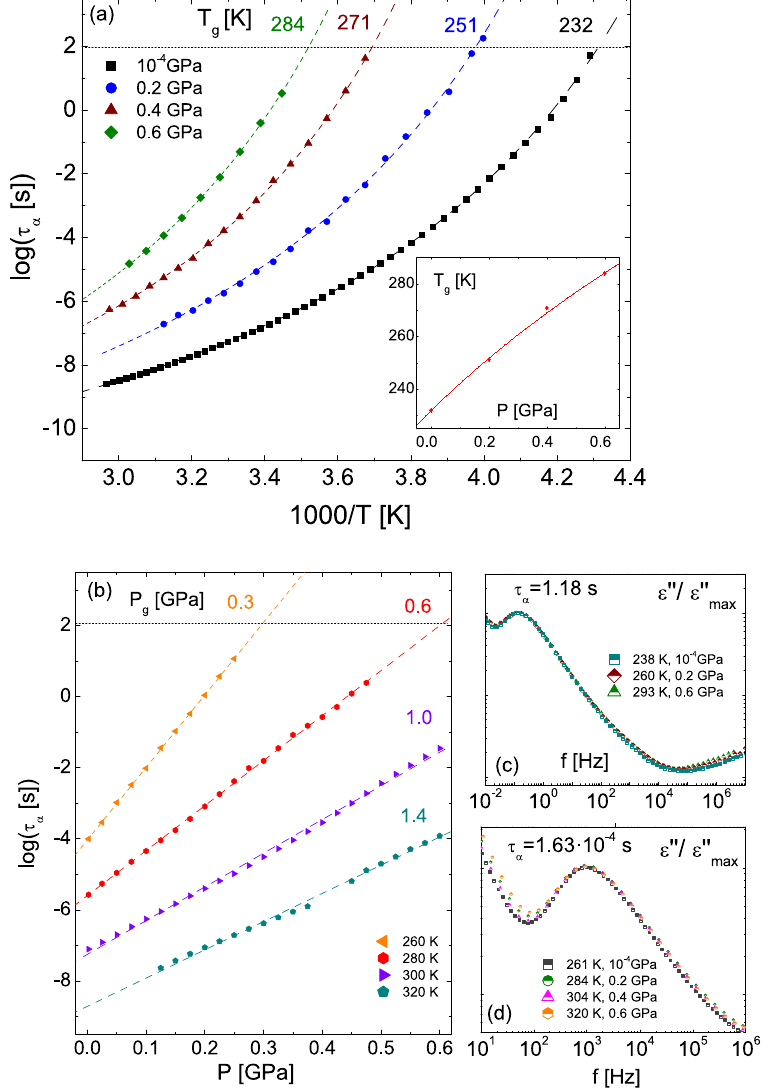
Figure 2. ( a , b ) Relaxation times of the α process as a function of the reciprocal temperature for a set of four pressures ( a ), and as a function of pressure, for a set of four temperatures ( b ), as indicated . The dotted lines correspond to fits with the Vogel-Furcher-Tammann Eq. 2 in panel (a) and with the pressure-dependent Arrhenius Eq. 4 in panel (b). Inset to ( a ): dependence of the glass transition temperature upon pressure for the data in ( a ), and fit according to Eq. 3. ( c , d ) Series of dielectric loss spectra for two sets of different pressure and temperature conditions, corresponding to the same α -relaxation time τ α = 1.18 s ( c ) and τ α = 1.63 · 10 − 4 s ( d ). The data were normalized to the same dielectric strength and shifted horizontally only slightly to allow a better visual comparison of the